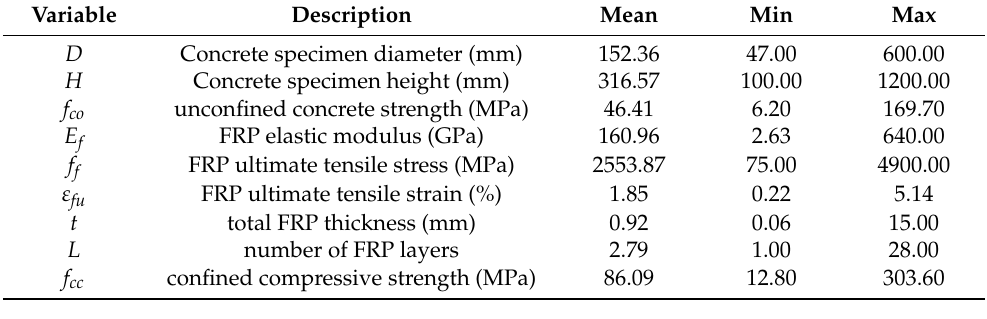
Table 2. Dataset parameters and statistical properties.